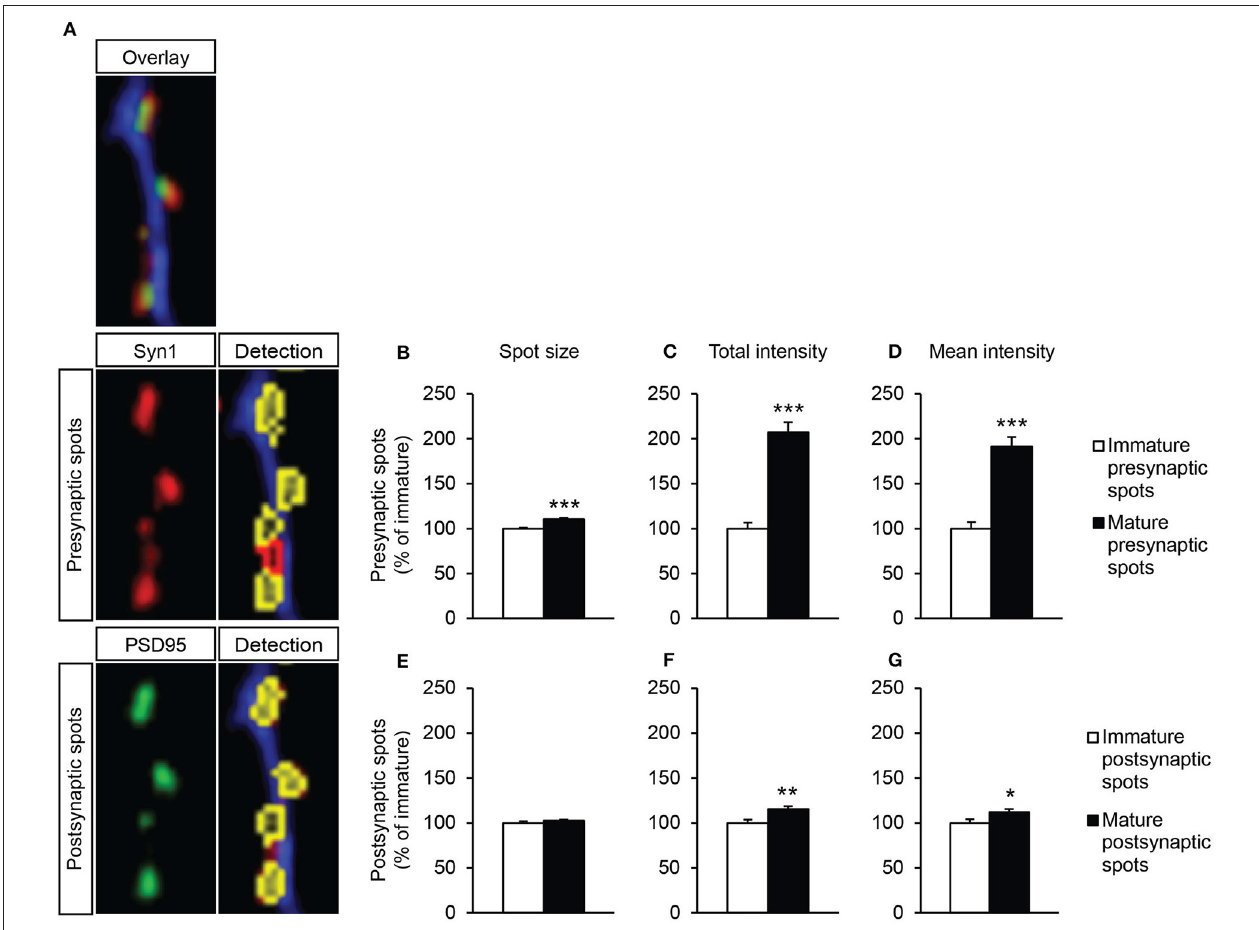
FIGURE 7 | Synapse morphology analysis of non-supplemented neuron-astrocyte co-cultures by Columbus software. (A) Zoomed-in example images taken with 40x objective. In red: synapsin1-positive presynapses, in green: PSD95-positive postsynapses. Both are followed by detection of immature presynapses (red) or mature synapses (yellow). (B–D) Analysis of presynaptic spots. (E–G) Analysis of postsynaptic spots. (B,E) Spot size. (C,F) Total intensity of all pixels within a spot. (D,G) Intensity corrected for spot size (per spot: total intensity/ µ m 2 spot area). Data were normalized to immature spot condition. Error bars represent standard error of the mean (SEM), n = 11 wells per condition, * p < 0.05, ** p < 0.01, *** p <